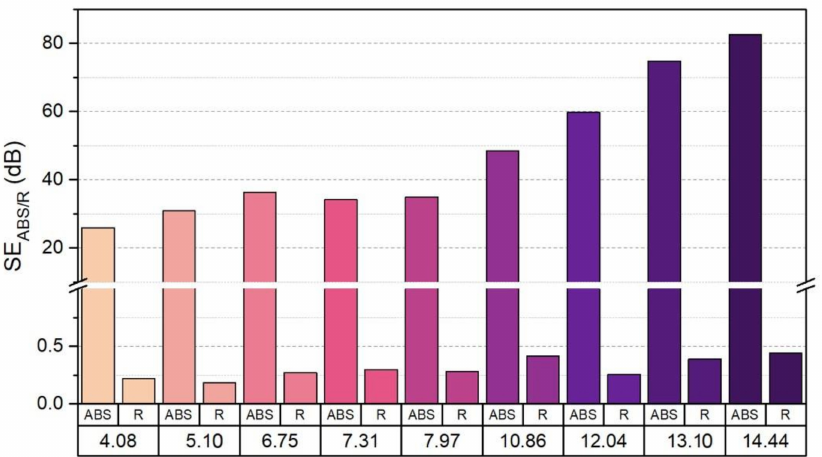
Figure 3. Comparison of the absorption and reflection components of total SE at 0.9 THz for samples with different CB